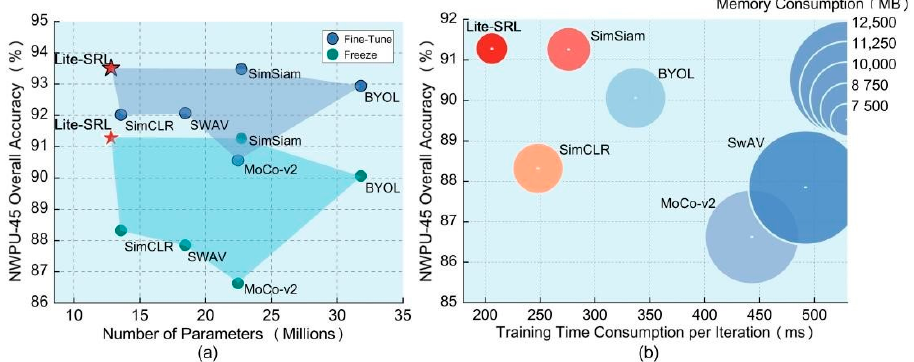
Figure 7. Guaranteed accuracy with less computation. ( a ) Fine-tune and freeze experiment results on NWPU-45 dataset with training proportion of 20%, the horizontal axis compares the number of parameters. ( b ) Freeze experiment results on NWPU-45 dataset with training proportion of 20%; horizontal axis compares the training time consumption per iteration, and the diameter of the bubble is proportional to the memory consumption during network